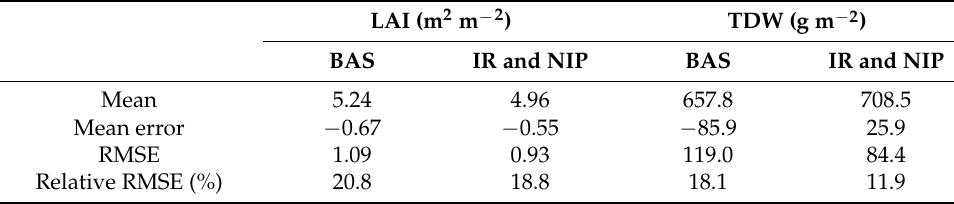
Table 1. Estimation accuracy of leaf area index (LAI) and total dry weight (TDW) in 2018 (Rep.